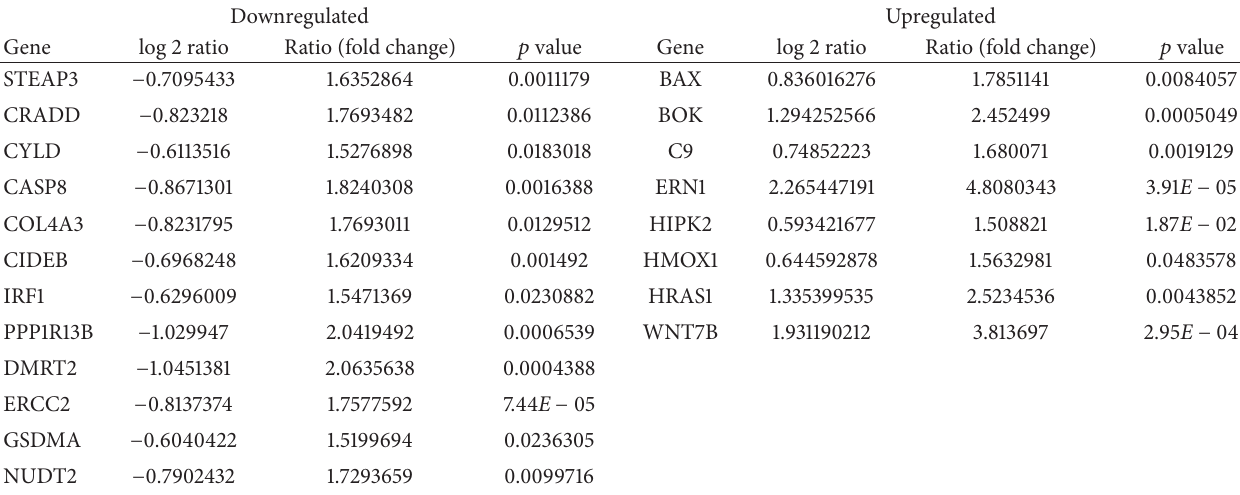
Table 1: MicroRNA-208a upregulated or downregulated genes involved in